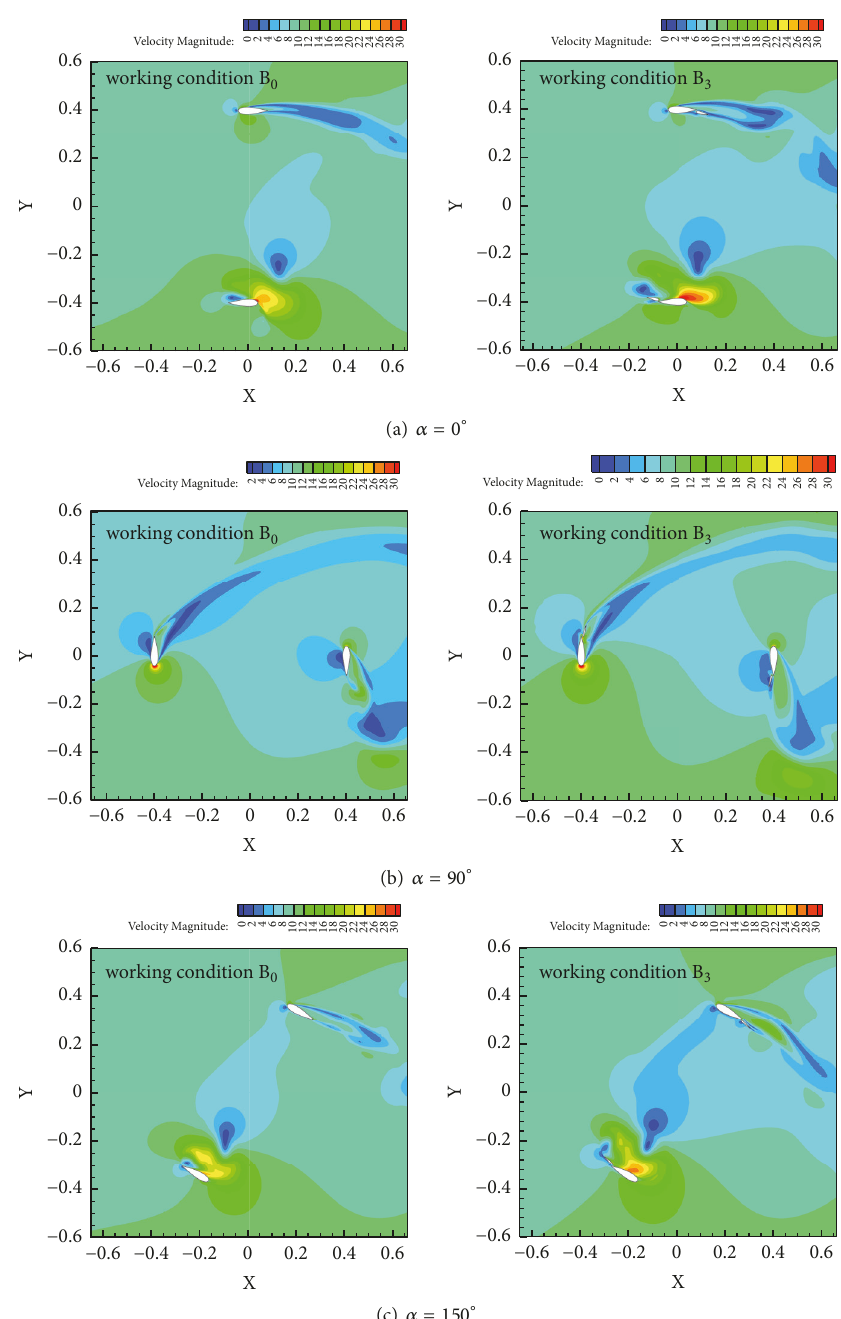
Figure 11: Velocity contours of working condition